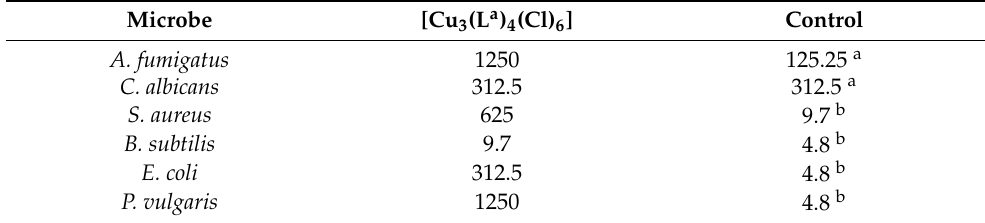
Table 5. MIC values ( µ g/mL) for the [Cu 3 (L a ) 4 (Cl) 6 ]